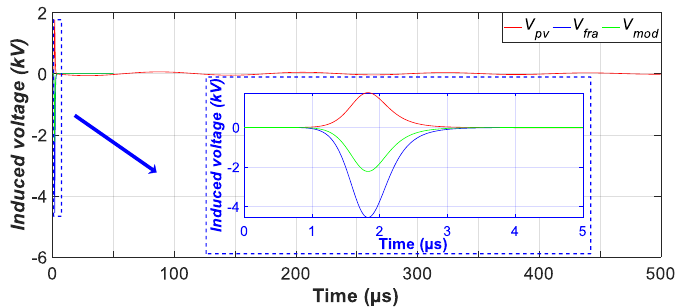
Figure 11. Reference case, induced voltages at the PV module. Vertical lightning channel with a first short stroke waveform hitting 5 m away from the module for an aluminum frame.